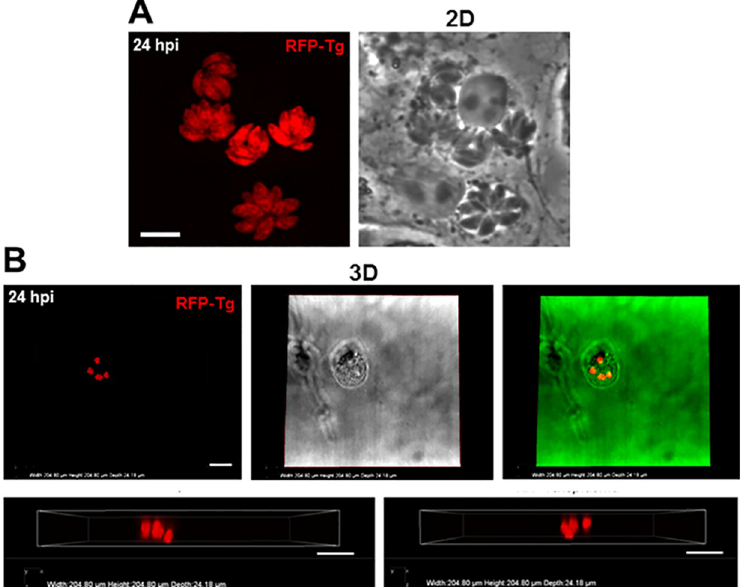
Fig 3. Morphology of infected cells and PV within VERO cells in 3D collagen matrix. A. Fluorescence microscopy at 40x of live multi-infected VERO cells with RFP-expressing Toxoplasma grown in 2D culture for 24 h showing flat rosette formation. Scale bar, 10 μ m. B. Fluorescence microscopy at 40x of live multi-infected VERO cell with RFP- expressing Toxoplasma grown in 3D culture for 24 h (left), bright field image (middle) and overlay image that have been pseudo-colorized in green to increase contrast. The top row shows a top-down view and the row below two side- on views. Images reveal 4 globular PV at different depths within a single cell. Scale bar, 25 μ m.